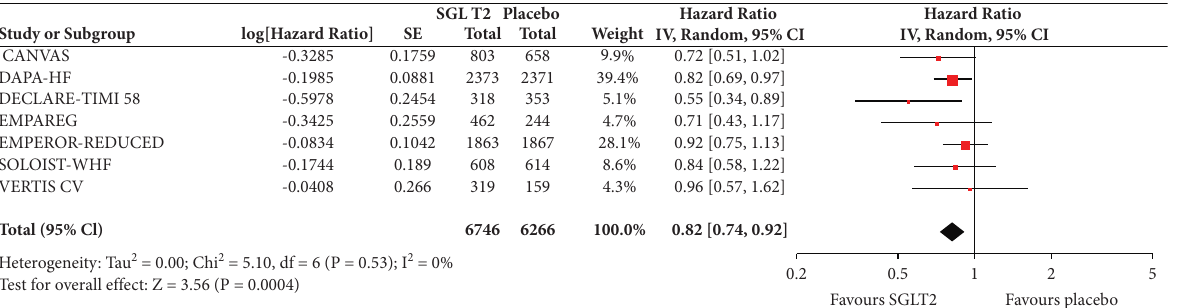
Figure 3: Effect of SGLT2 inhibitors versus placebo on cardiovascular death for the total population.